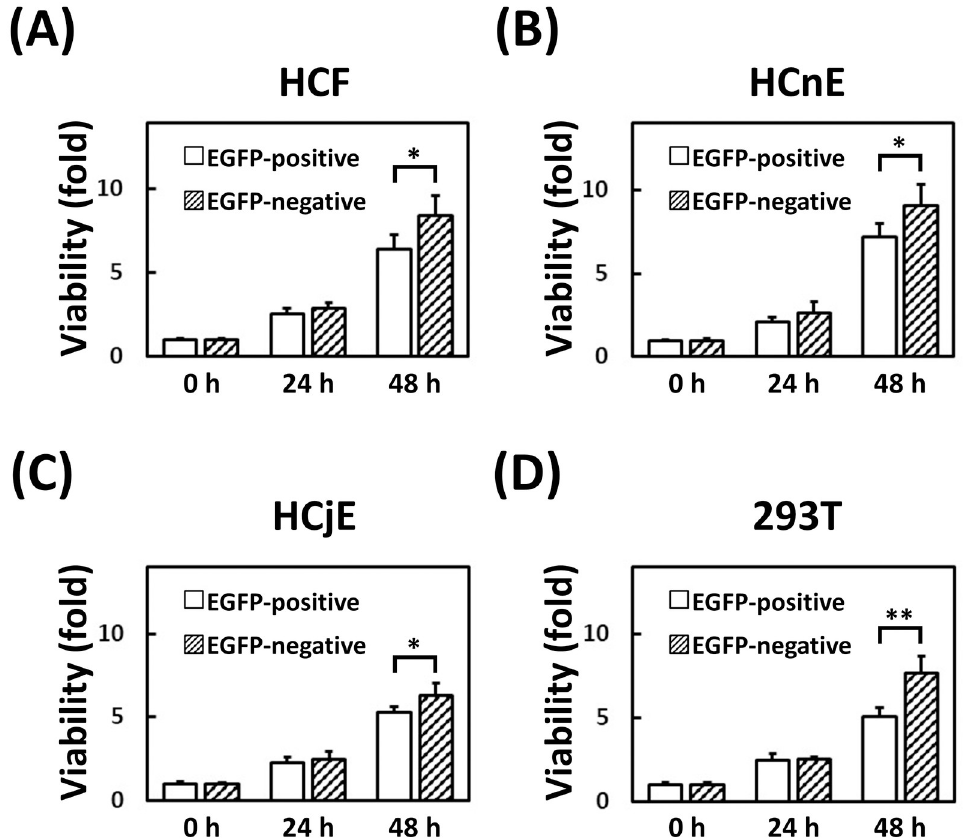
Fig 3. Viability of the sorted EGFP-expressing cells. Each cell type was seeded into individual wells of a 96-well plate: (A) 2.0 × 10 3 HCFs, (B) 2.0 × 10 4 HCnEs, (C) 2.0 × 10 4 HCjEs, and (D) 2.0 × 10 4 HEK-293T cells. At 24 h post-seeding as the starting time (0 h), cell viability was analyzed at 0, 24, and 48 h by CCK-8 reagent. Data are expressed as the mean ± S. D. from three independent experiments. The upper bars represent the S.D. of the mean. Differences in the viability of EGFP-positive and EGFP-negative cells were analyzed with the Student’s t -test ( � P < 0.05; �� P < 0.01).